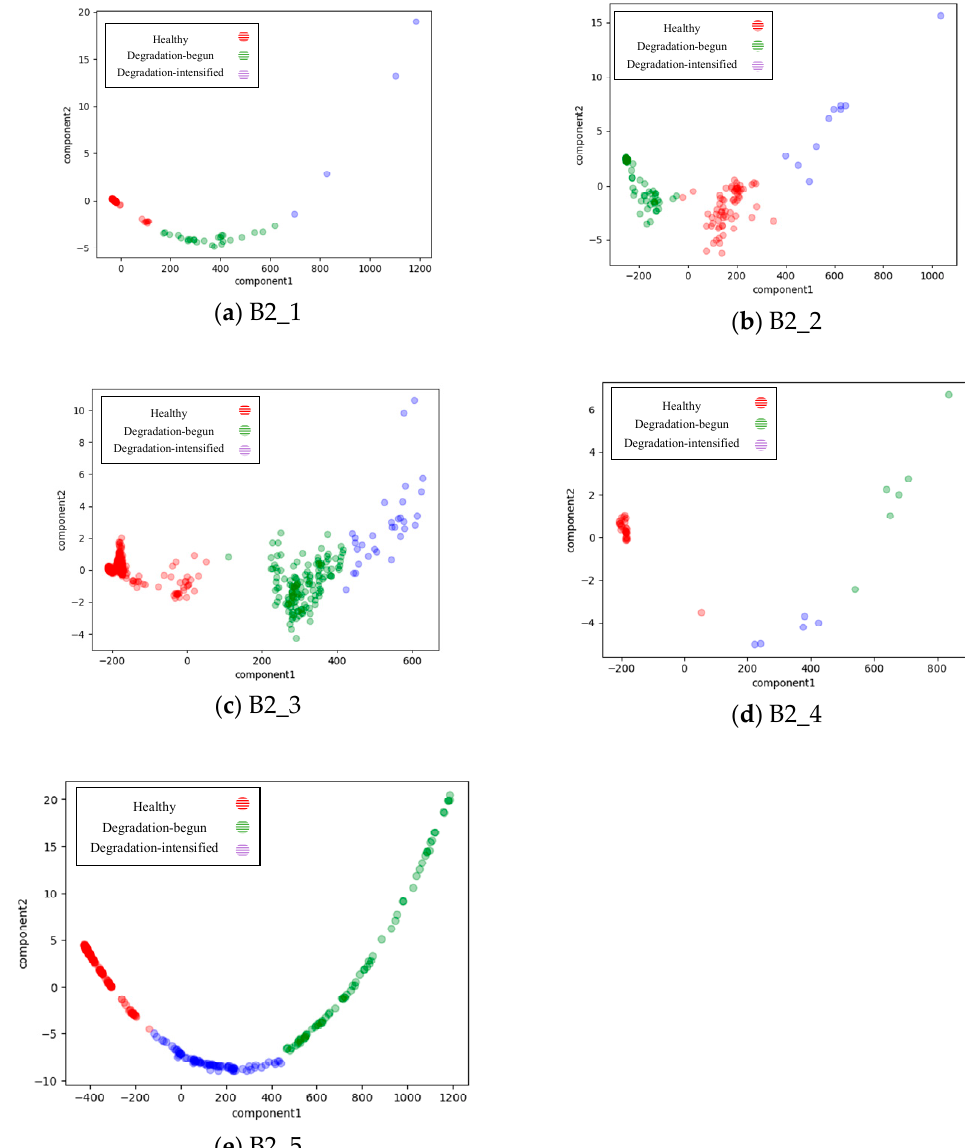
Figure 8. Clustering result of bearing useful life data under working condition 2.